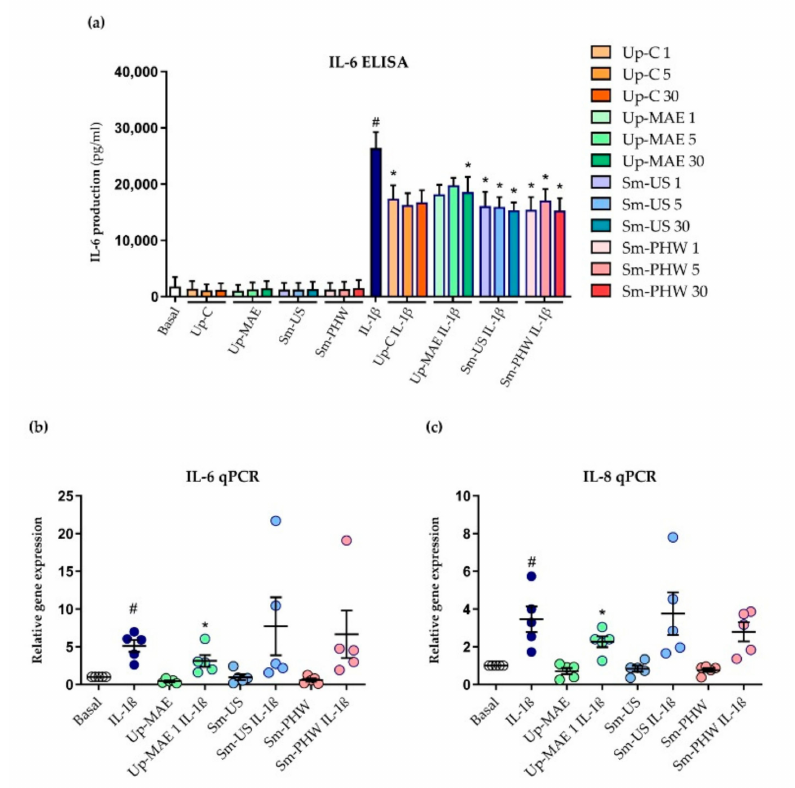
Figure 7. Effect of crude fucoidans on inflammatory response induced by IL-1 β in 260TT cell line. ( a ) IL-6 production was measured at protein level by IL-6 ELISA ( n = 4) in cells stimulated as previously indicated for 24 h. IL-6 ( b ) and IL-8 ( c ) gene expression was analyzed by qPCR ( n = 4) in cells treated with crude fucoidans at 5 µ g/mL with and without IL-1 β for 6 h. IL-1 β condition is statistically different from basal condition (#: p -value < 0.05). Conditions marked with * are statistically different from IL-1 β condition (*: p -value <